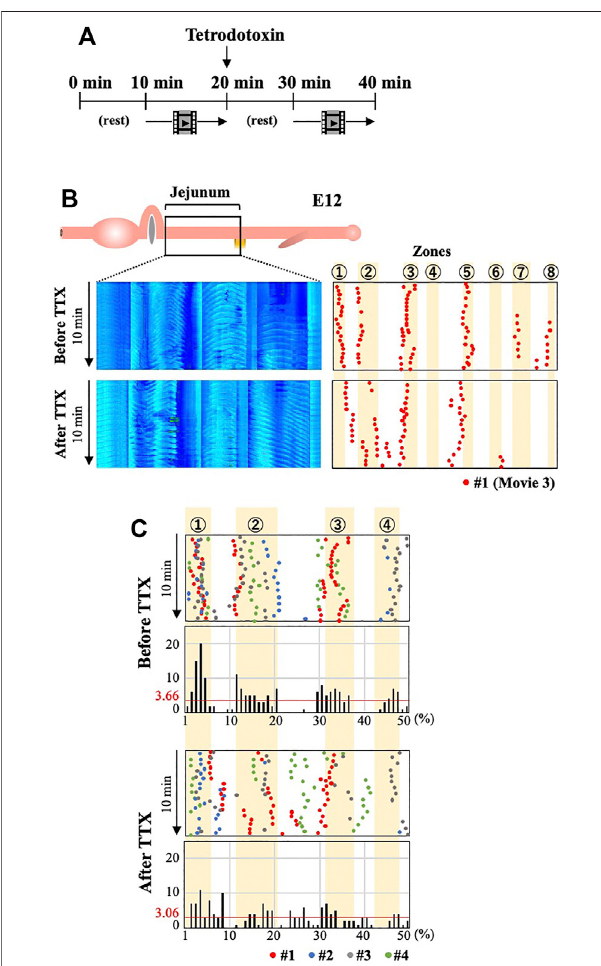
FIGURE 5 | Blocking neural activity of ENS by TTX causes aberrant distribution of OPWs in the jejunum at E12. (A) Video-recording for 10 min in normal medium is followed by a rest and second recording in TTX-containing medium. (B) Kymographs and OPW distribution maps of a single jejunum (#1; red) before and after administration of TTX. (C) Overlaid map for specimens #1 – #4 (red, blue, gray, green) in the anterior jejunum (50 positions) in a manner similar to Panel 4 . The total number of OPWs is 187 and 153 for before and after TTX.